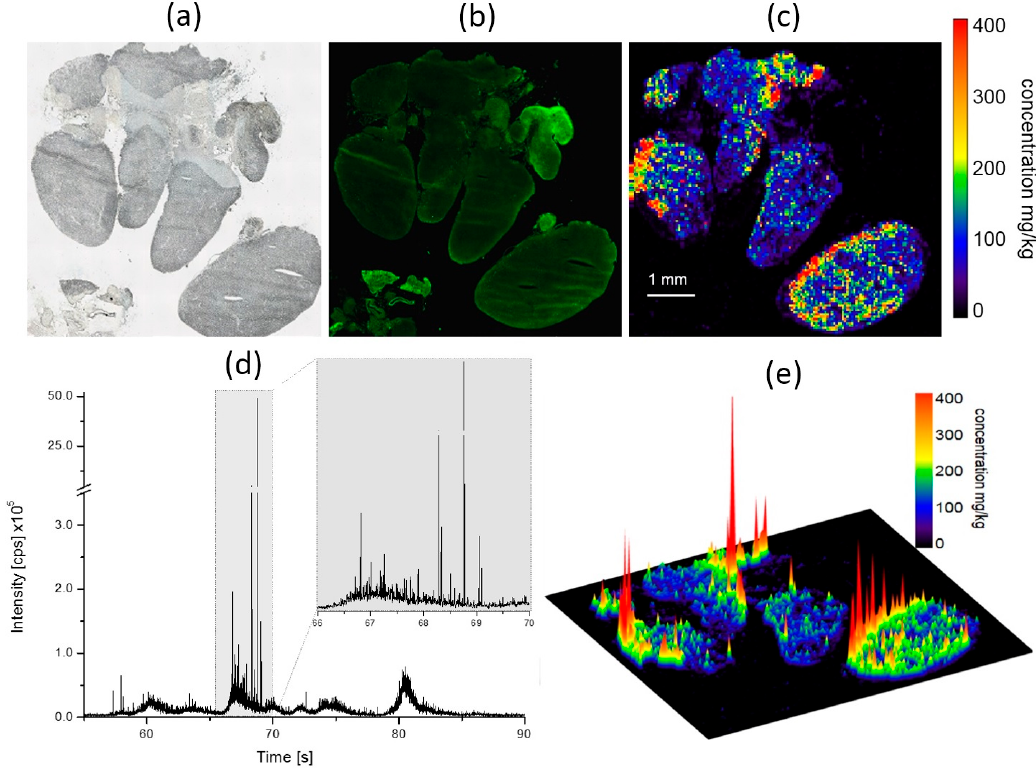
Figure 8. Distribution of silver in a collection of mediastinal lymph nodes 21 days post intratracheal instillation of 300 µg Ag50-PVP into the rat lung. Low power micrograph ( a ); auto-fluorescence ( b ) and quantitative Ag distribution images determined by means of laser-ablation inductively-coupled mass spectrometry shown as two- ( c ) and three-dimensional plots ( e ); ( d ) shows a (non-calibrated) single-line scan measured in counts per second (cps). High impact peaks represent aggregated or particulate Ag depositions. Pseudocolor scales of the Ag concentration in ( c ) were adapted to organ concentration. Maximum values are described in the text.